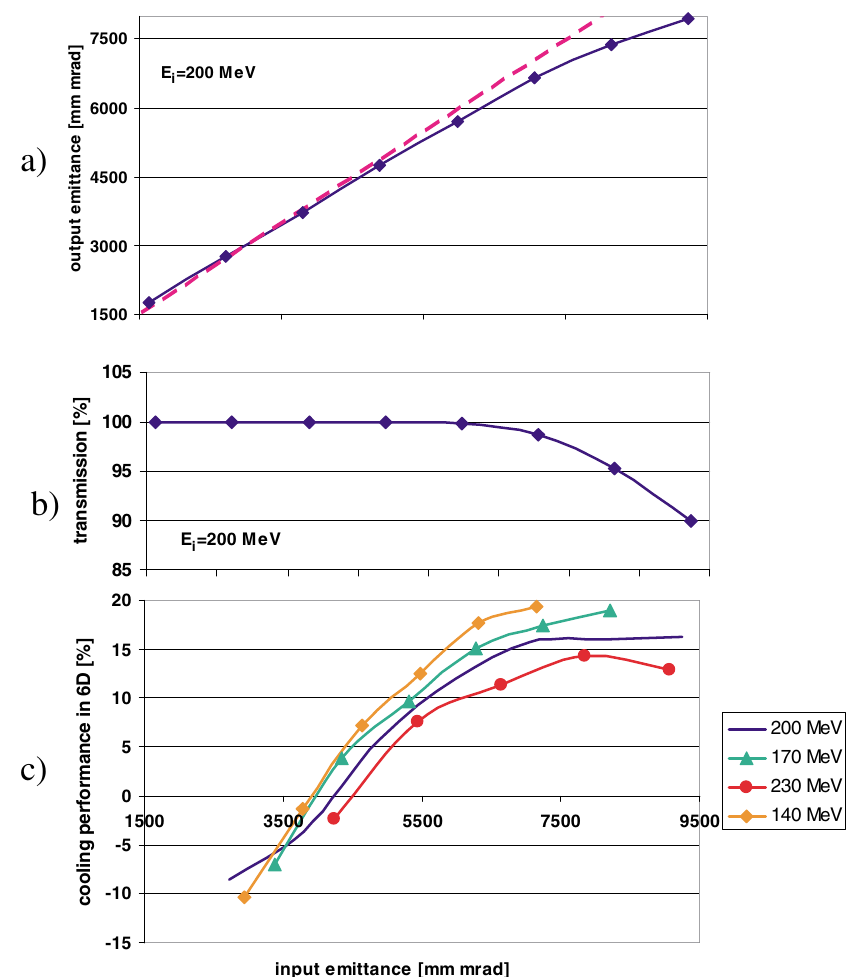
FIG. 51. (Color) Simulation results for 88-MHz variant of MICE apparatus: (a) output emittance vs input emittance, with 45 (cid:28) line (dashed line) superimposed; (b) beam transmission vs input emittance; (c) cooling performance (see text) vs input emittance for various beam kinetic energies (top to bottom: 140, 170, 200, and 230